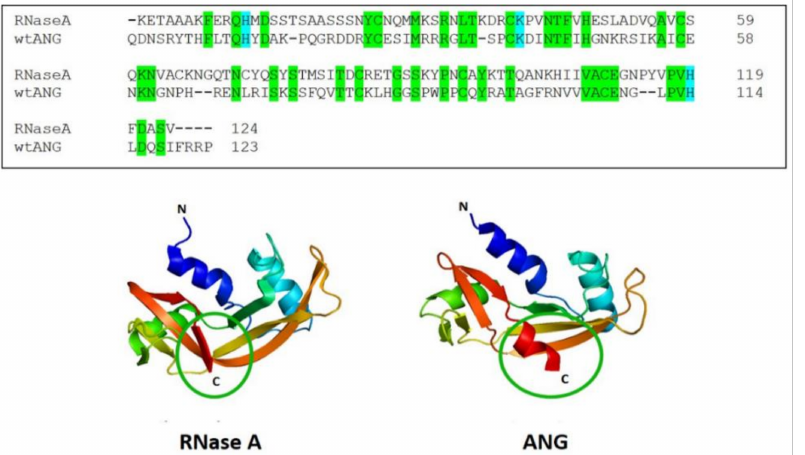
Figure 1. RNase A and ANG. Primary ( upper panel ) and 3D structures ( lower panel ) of RNase A and ANG (5RSA.pdb and 1ANG.pdb, respectively). In the sequence, the common residues are highlighted in green, while the catalytic triad is in light blue. In the lower panel, the different regions, especially the helices, are shown with different colours, while the different conformations of the C-termini of ANG are